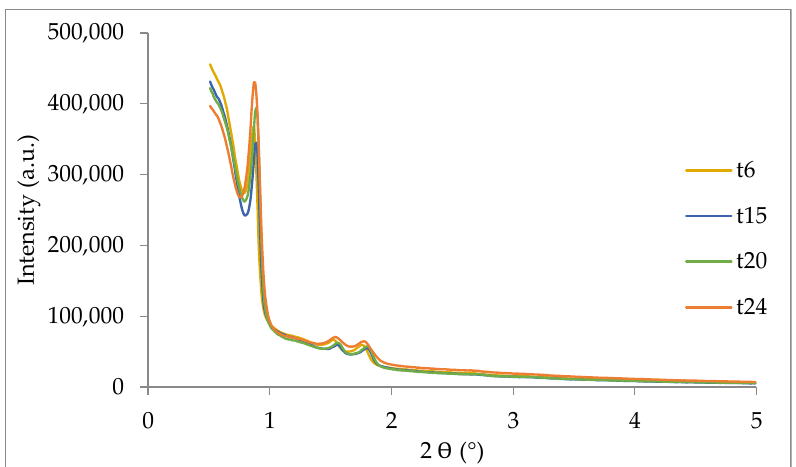
Figure 1. Low angle X-ray diffraction patterns of samples for the study of the influence of time.